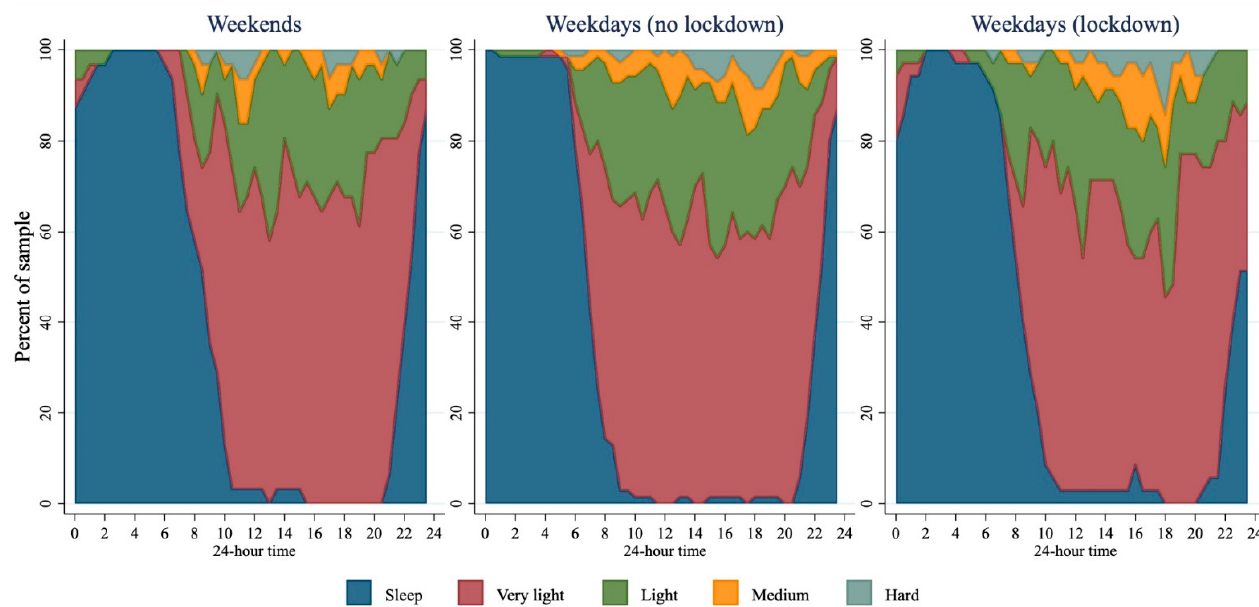
Figure 3. Intensity of activity across 24 h for weekends ( n = 31), weekdays before lockdown ( n = 72), and weekdays during lockdown ( n = 35). Very light intensity—activities that involve very little or no movement, breathing rate is slow; Light intensity—activities that involved some movement, but do not elevate breathing rate; Medium intensity—moving quickly/briskly, breathing rate is increased but you can still talk; Hard/vigorous intensity—moving very quickly, breathing so hard you cannot talk at the same time.